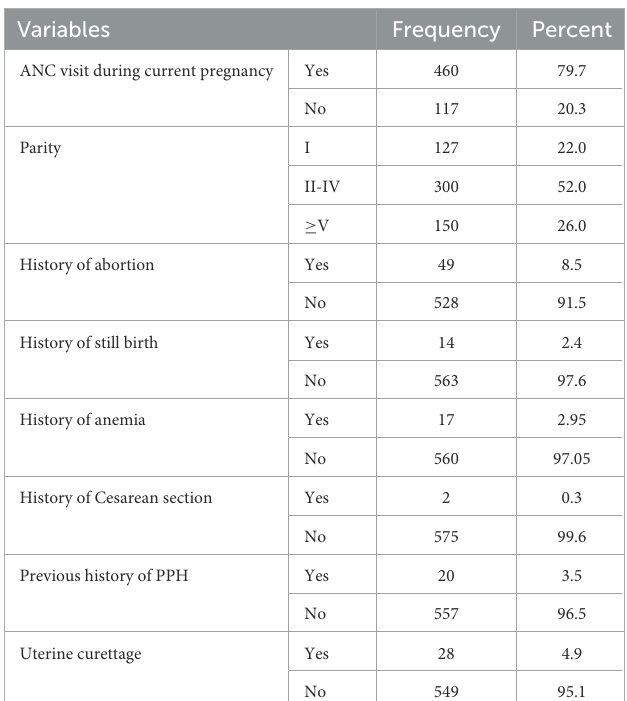
TABLE 4 Distribution of delivering women by their hemodynamic condition in the district areas health centers of Gedeo Zone, Southern Ethiopia, 2021 ( N = 577).